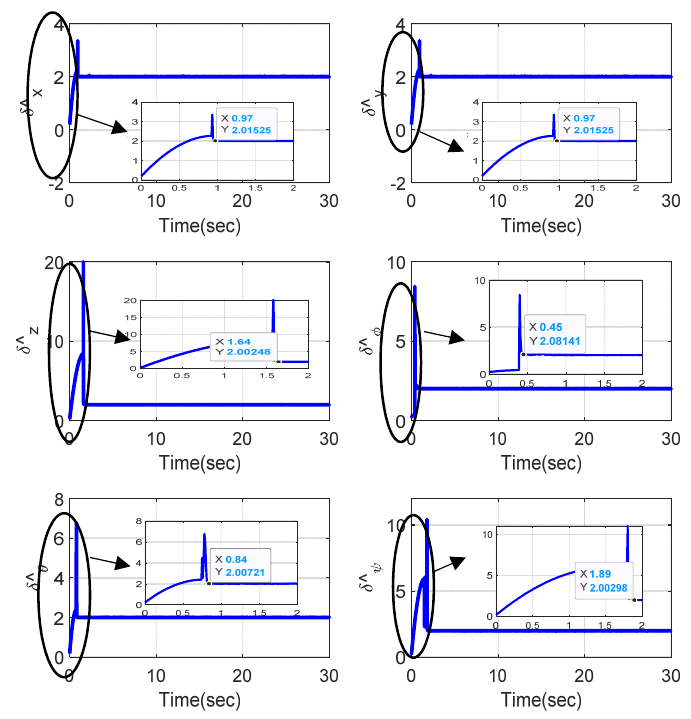
Figure 8. Time histories of the barrier function.